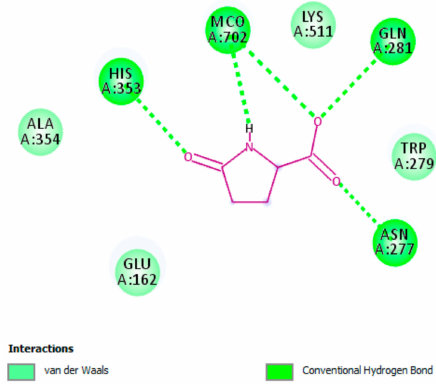
Figure 3. A two-dimensional interaction scheme of pyroglutamic acid (pGlu) with the catalytic site of angiotensin-converting enzyme. Essential hydrogen bonding interactions along with van der Waals interactions with residues of the catalytic site, which are crucial for inactivating the enzyme, are